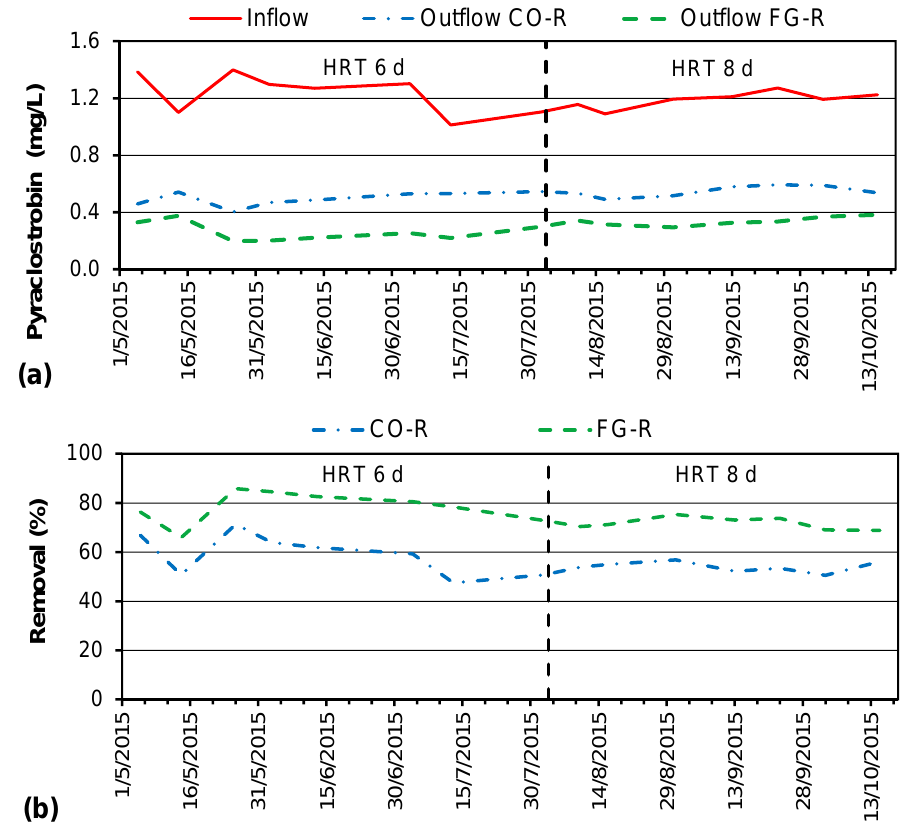
Figure 3. ( a ) Variation of pyraclostrobin concentration in pilot-scale CW influent and effluents; ( b ) removal efficiencies (%).